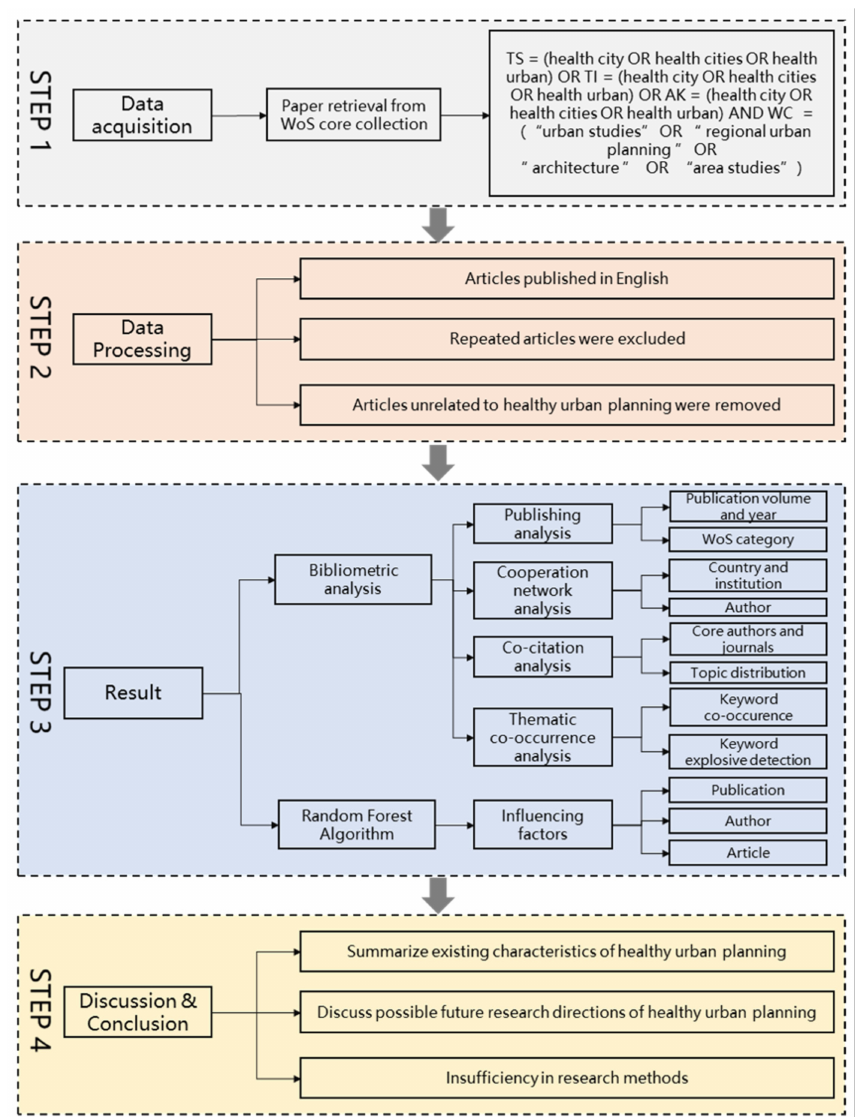
Figure 1. The outline of research